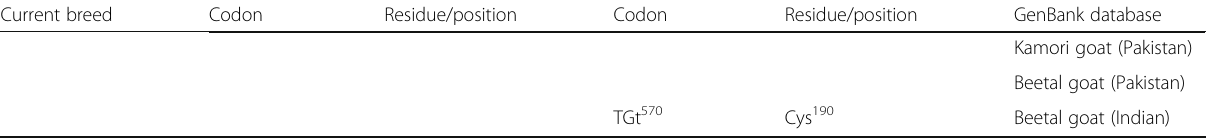
Table 2 Multiple alignment of Bo_GH cDNA sequence with GenBank goat database (Continued) Current breed